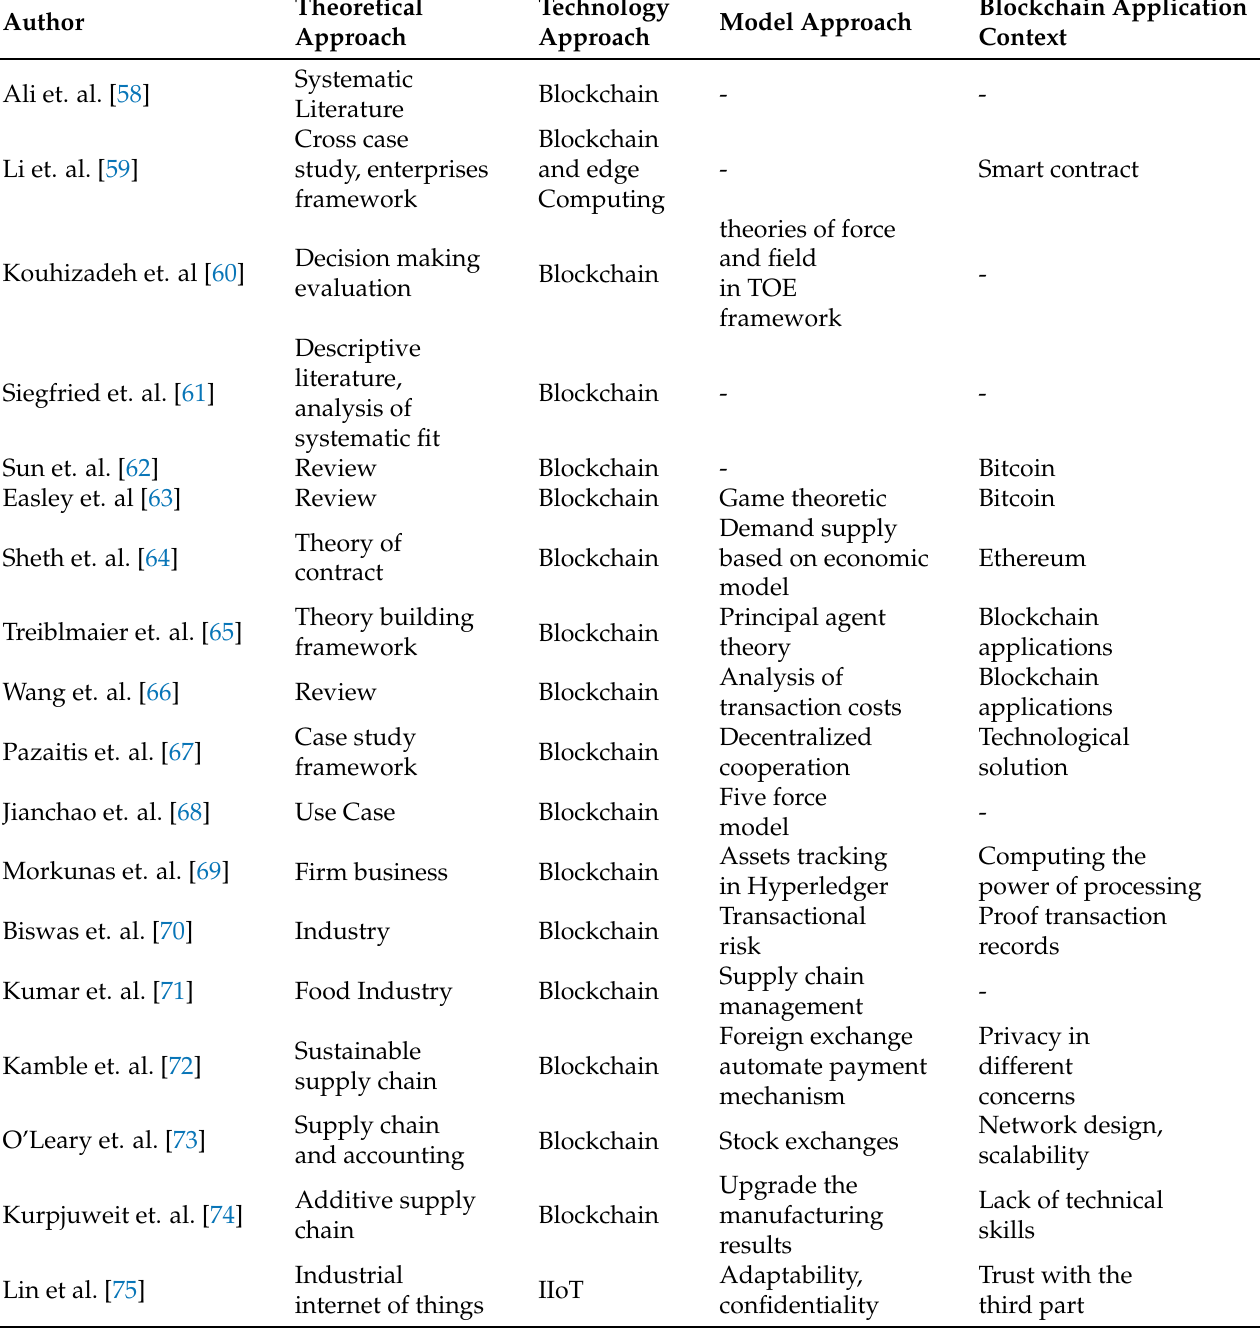
Table 1. Related studies of blockchain’s challenges and